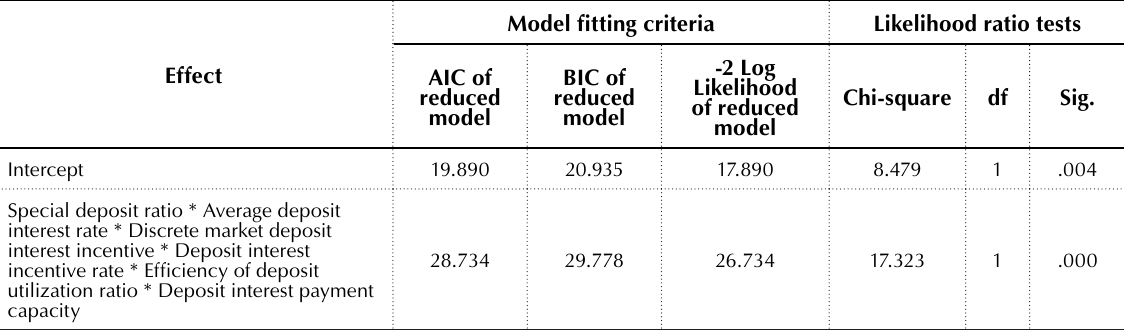
Table 27. Likelihood ratio tests of stable deposit